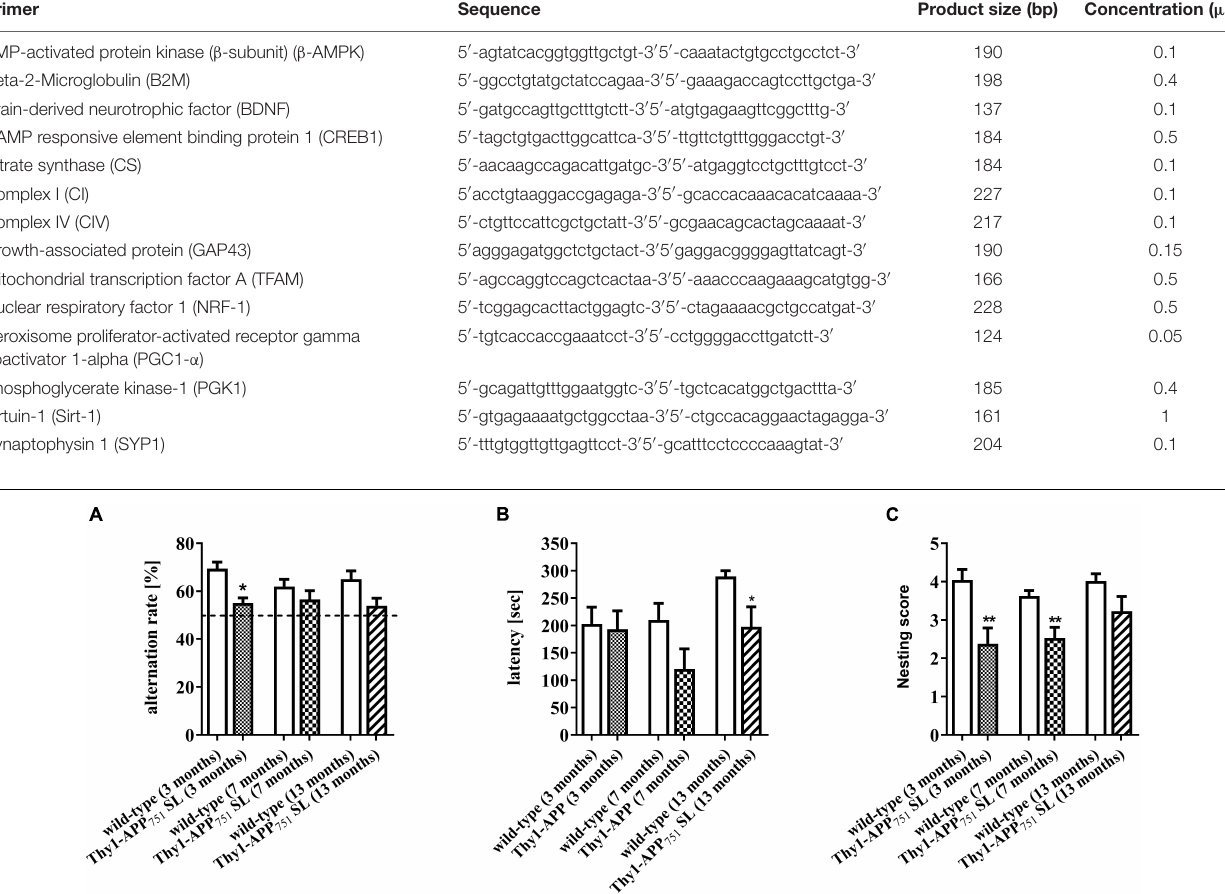
FIGURE 2 | Alternation rate in the Y-Maze spontaneous alternation test (A) , latency time day 2 in the Passive Avoidance test (B) , and nesting scores (C) of 3, 7, and 13 months old